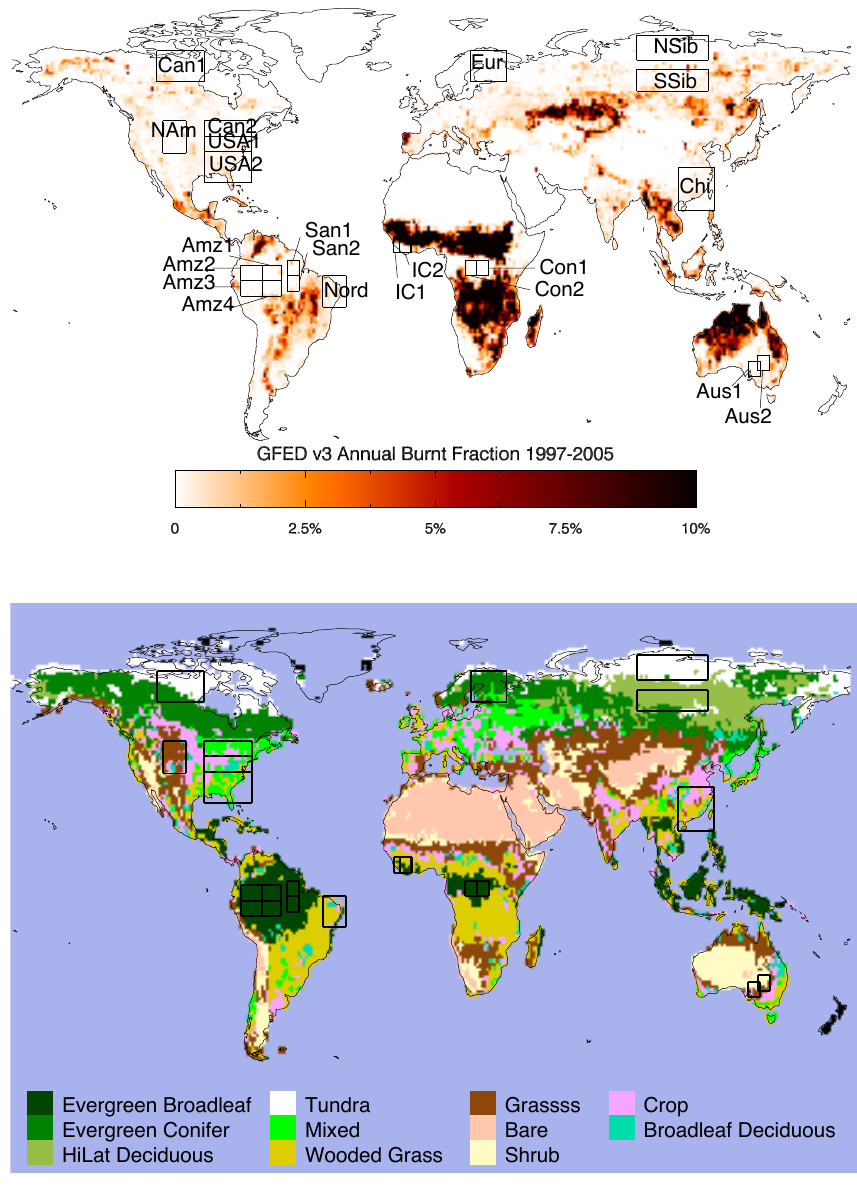
Figure 2. Geographic distribution of the regions analysed, overlayed on burnt area and biomes. Average burnt fraction (1997–2005) from version 3 of the Global Fire Emissions Database (van der Werf et al., 2010) is shown in the top panel. The bottom panel shows the land classification, following deFries and Townsend